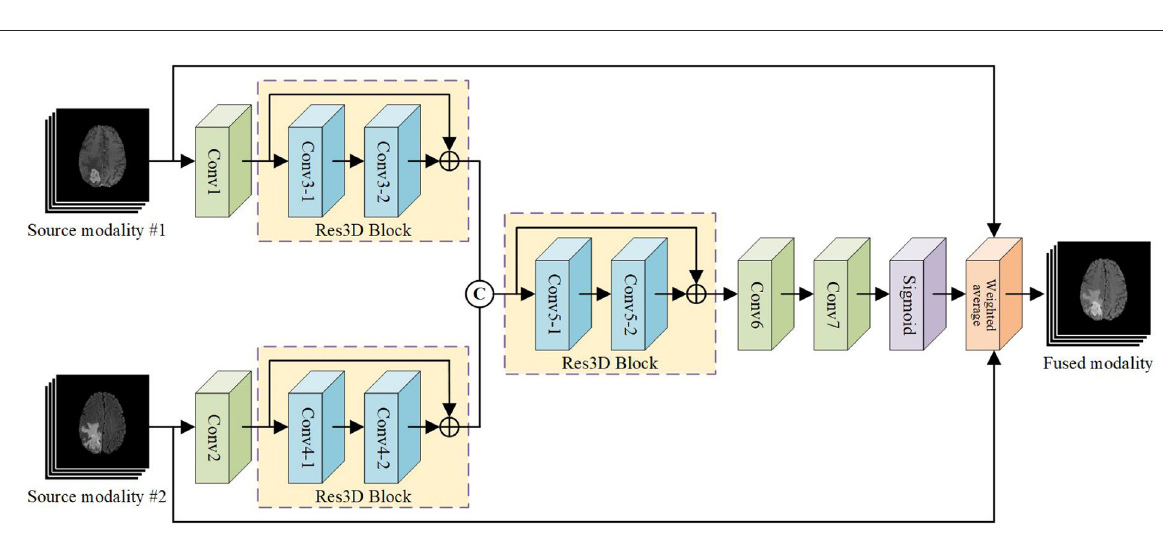
FIGURE3 The architecture of our PIF-Net for 3D multimodal MR image